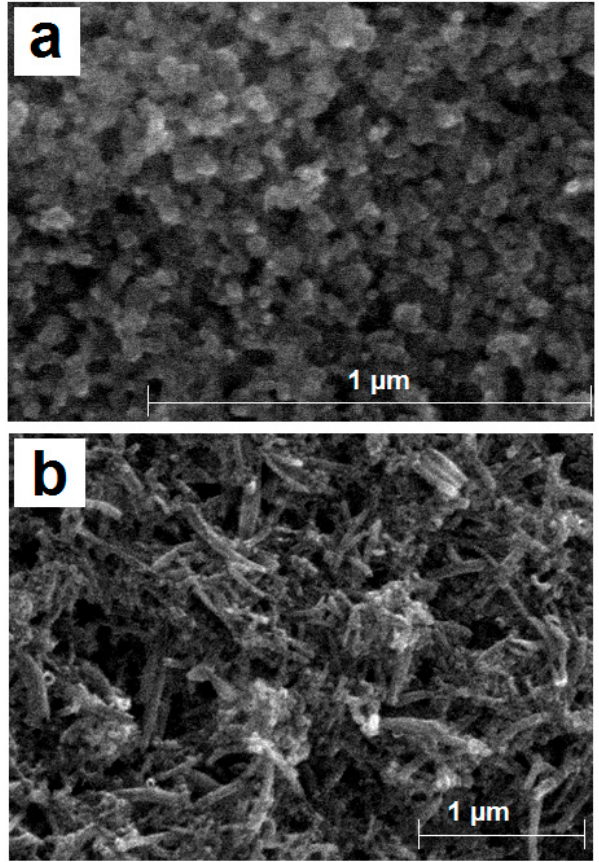
Figure 1. SEM images of ( a ) SPE using acceleration voltage as 5 kV, ( b ) CNF-SPE using acceleration voltage as 10 kV with the resolution of 1 µm.